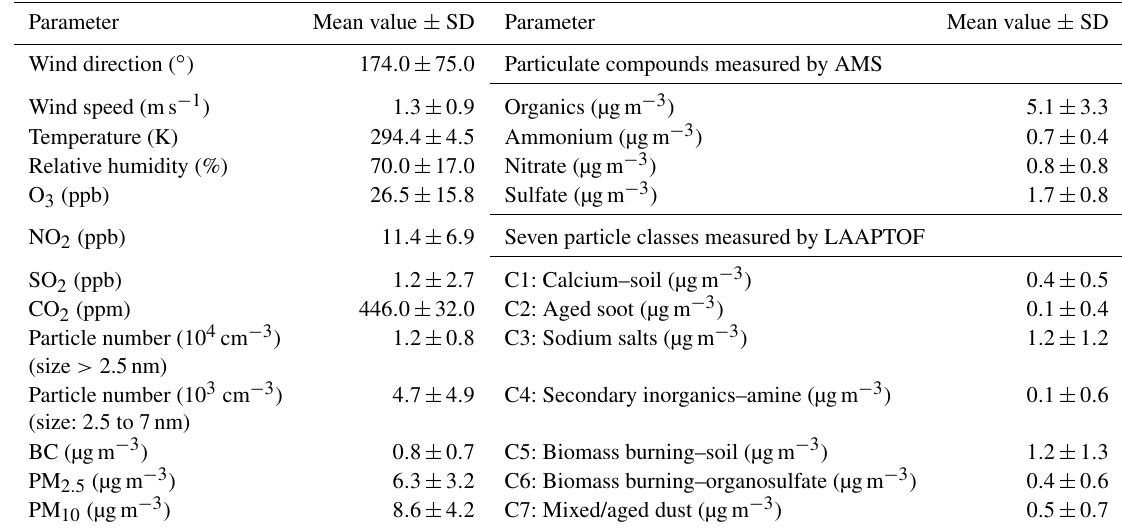
Table 1. Mean values ( ± SD) of characteristic parameters for the entire measurement period. Parameter Mean value ± SD Parameter Mean value ± SD Wind direction ( ◦ ) 174 . 0 ± 75 . 0 Particulate compounds measured by